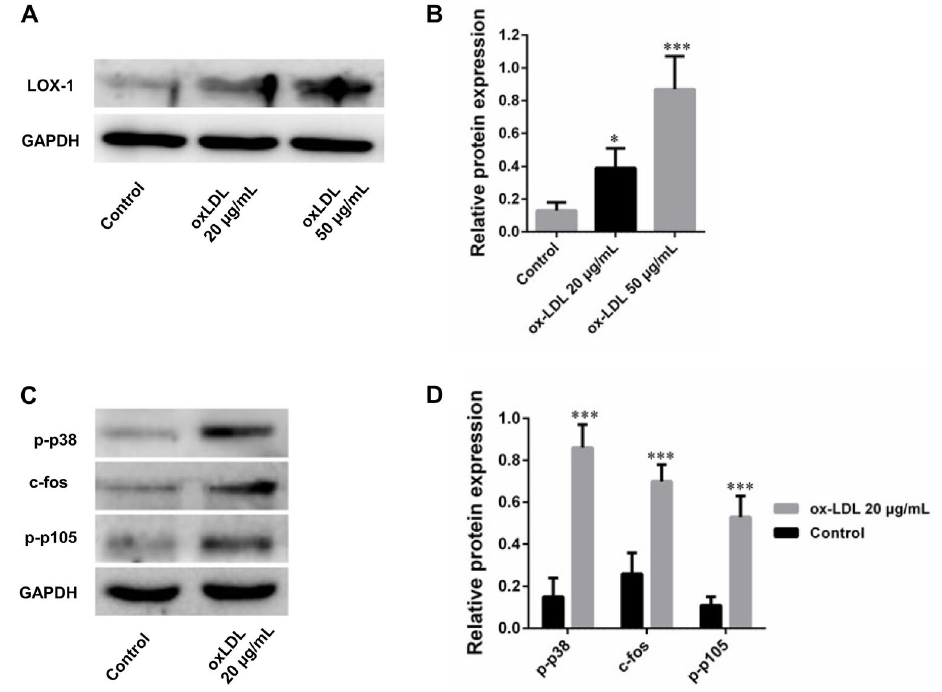
Figure 2. Lectin-like oxidized low-density lipoprotein receptor-1 (LOX-1) expression and MAPK/NF- k B pathway in dendritic cells (DCs) stimulated by oxidized low-density lipoprotein (oxLDL) ( A and B ). C and D , Expression of p-p38, c-fos, and p-p105 in DCs after treatment by oxLDL. Data are reported as means ± SD (n=3). *P o 0.05 vs control, ***P o 0.01 vs control